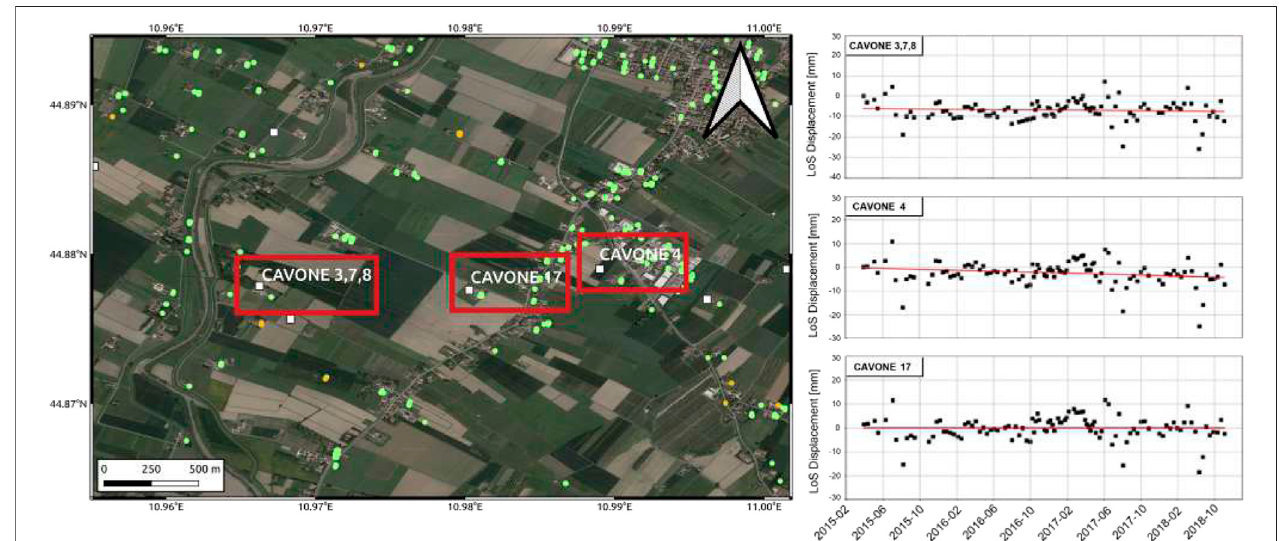
FIGURE 10 | Focus on some wells of the Cavone oil fi eld: InSAR time series extracted from point targets in proximity of the wells shown on top.